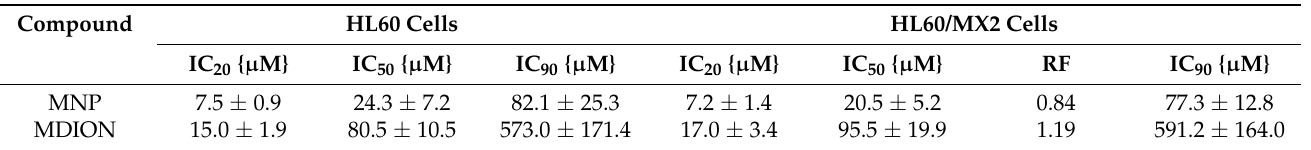
Table 1. The ability of MNP and MDION to inhibit the growth of sensitive HL60 and resistant HL60/MX2 leukaemia